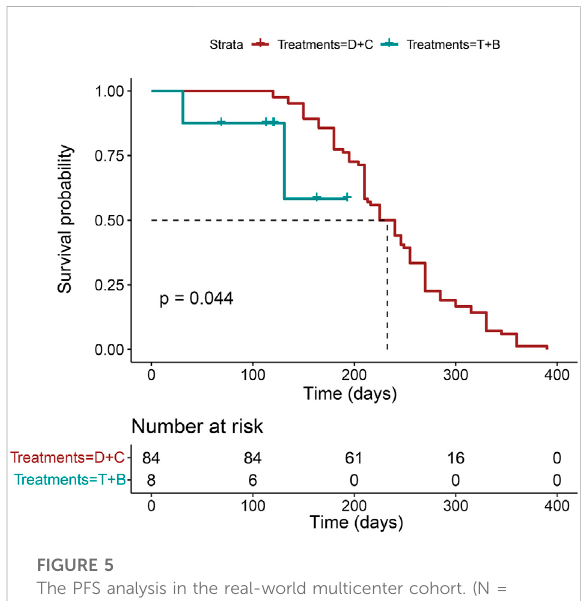
FIGURE 5 The PFS analysis in the real-world multicenter cohort. (N = 92, p = 0.044, log-rank test. B: bevacizumab; C: cetuximab; D: double-drug; P: panitumumab; T: